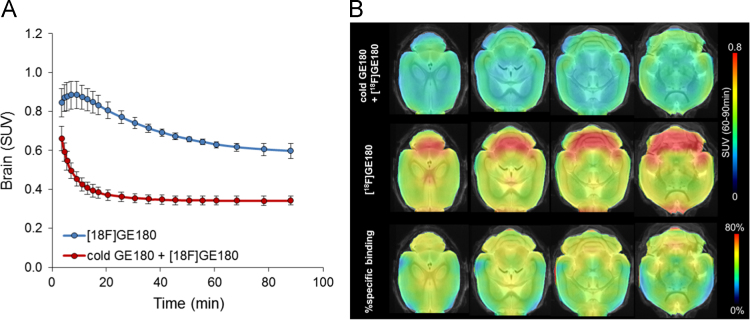
Dynamic and regional in vivo positron-emission-tomography (PET) measurements of the brain. (A) Mean dynamic brain PET standardized uptake value (SUV) plots for groups of unblocked (blue) and blocked (red) mice during 90 min after injection of [18F]GE180. Error bars indicate standard deviations. (B) Regional analysis shows axial slices of 60–90 min [18F]GE180 PET SUV projected upon a magnetic resonance imaging template [2]. Upper row illustrates mice with prior blocking by a large mass dose of GE180 (1000:1), whereas the middle row shows unblocked mice. Voxel-wise percentage of specific binding in the rodent brain is depicted in the bottom row. Highest specific binding was observed in regions with high abundance of ependymal glia cells, e.g. adjacent to the fourth ventricle, whereas specific binding in the cortex was low. Data derive from N = 3 unblocked and N = 5 blocked C57Bl/6 mice at seven months of age. Error bars indicate standard deviations. Single data points are available in the supplement.